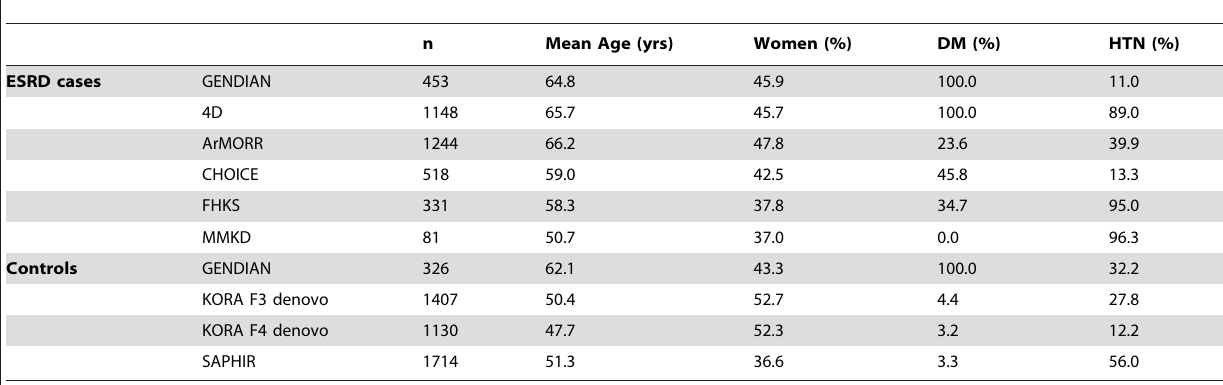
Table 3. Characteristics of the ESRD case-control studies (n =3,775 cases, n= 4,577 controls).